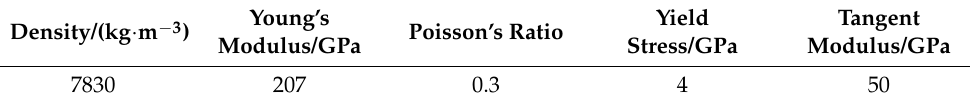
Table 3. Material parameters of nose cap. Figure 3. Compression stress–strain curve of buffer.